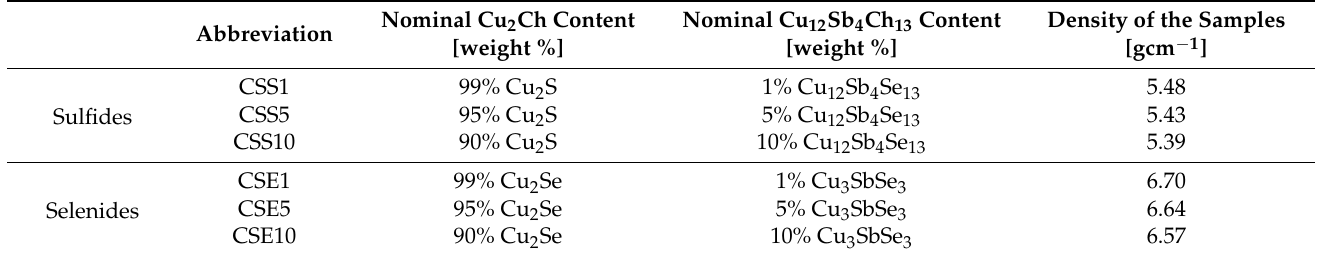
Table 1. Nominal compositions and densities of the synthesized samples and their